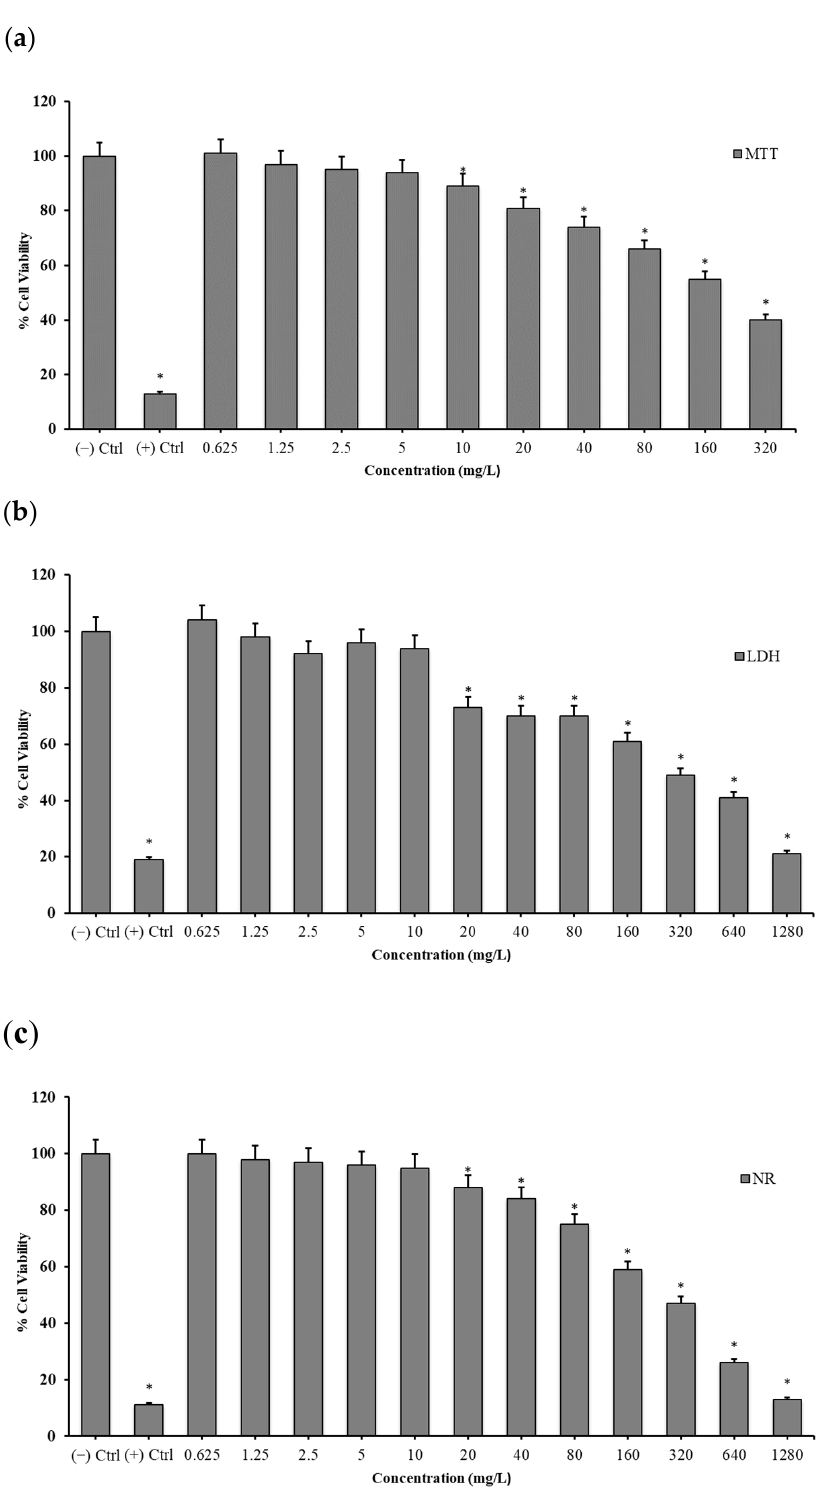
Figure 2. Characterization of zinc borate (Zn 3 BO 6 ) NPs. ( a )—scanning electron microscope (SEM) analysis of Zn 3 BO 6 NPs, ( b )—transmission electron microscope (TEM) analysis of Zn 3 BO 6 NPs and ( c )—X-ray crystallography (XRD) analysis of Zn 3 BO 6 NPs.